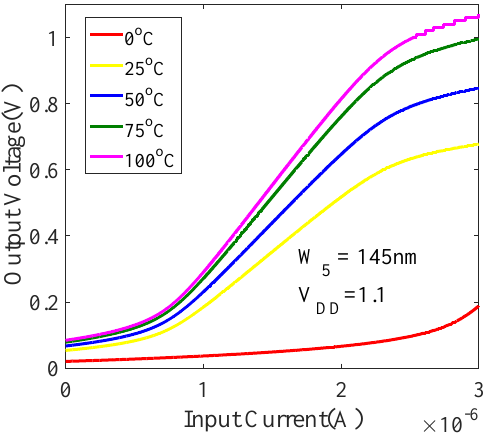
Figure 8. Transfer characteristics for the proposed sensor for 3 µ A range.